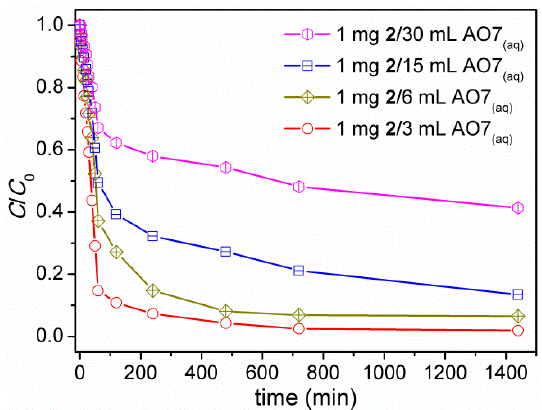
Figure 7. Relative concentration of AO7 versus time after the photocatalytic degradation by 2 and H 2 O 2 in different concentrations of 2 under daylight. Conditions: initial concentration of AO7 = 20 mg L − 1 , H 2 O 2 = 1 mL (30%).